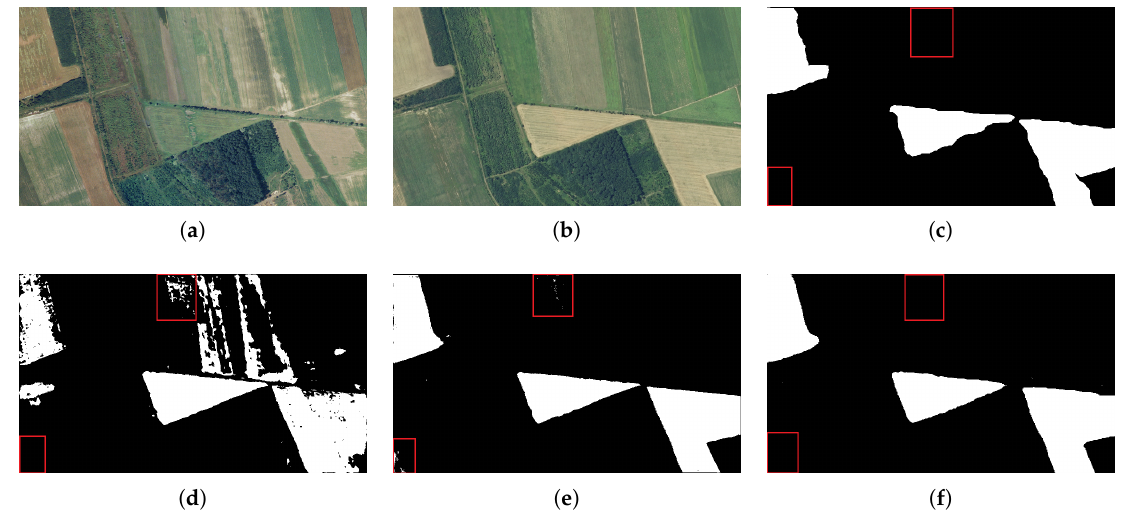
Figure 15. The results of different methods on TISZADOB/3. ( a ) Image one. ( b ) Image two. ( c ) Grounth truth ( d ) Result using FC-Siam-diff. ( e ) Result using the pseudo-siamese capsule network. ( f ) Result using the change capsule network.